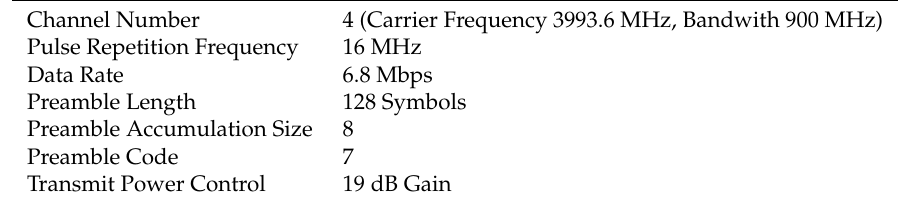
Table A1. The settings of the DWM1000 modules used to acquire the CIRs and range